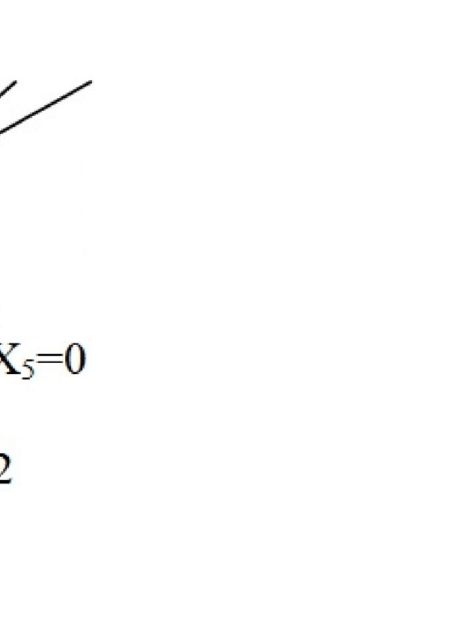
Figure 7. Realization stage of the optimal logic tree for X 1 = 1, X 3 = 2, X 5 = 2, X 4 = 1, and X 2 = 1, 2.